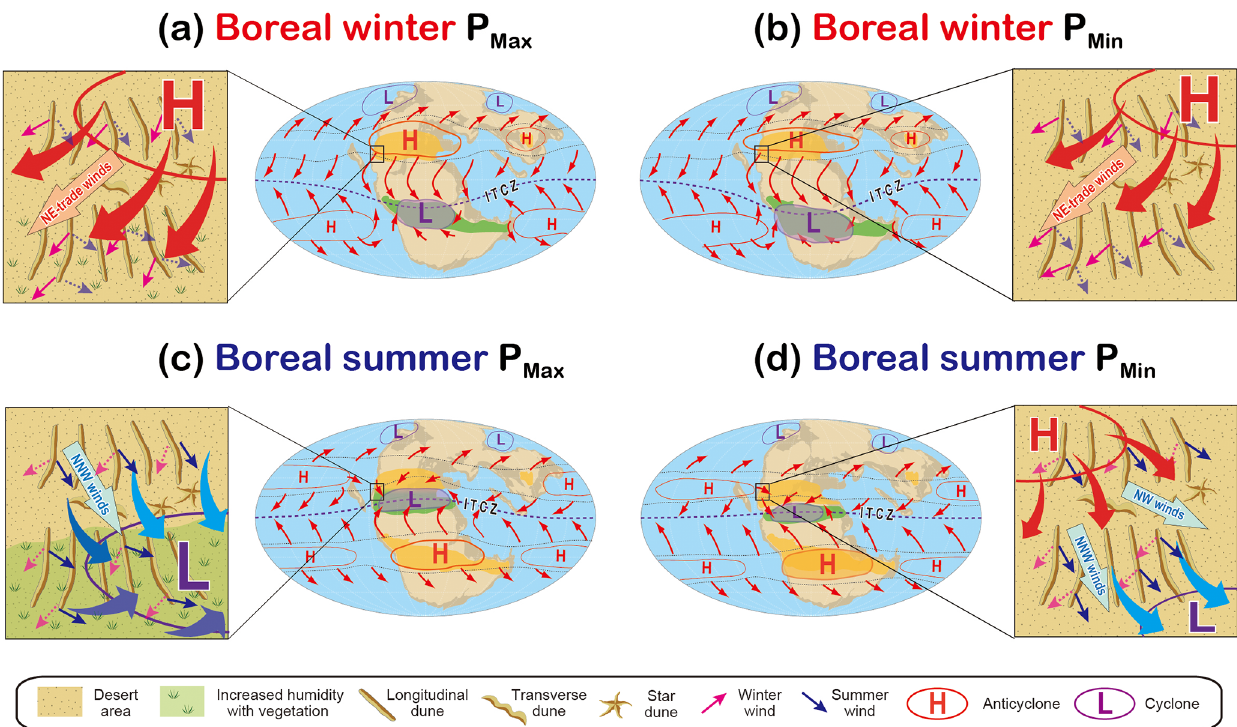
Figure 4. Schematic illustrations of orbital and seasonal changes in the Pangaean atmospheric pressure pattern and inferred dune alignments in the western US during the eccentricity-modulated precession maximum ( P Max ; a, c ) and minimum ( P Min ; b, d ). Orbital-scale changes in the pressure pattern are based on climatic model results (Winguth and Winguth, 2013). Seasonal changes in wind regimes are indicated as pink (boreal winter) and blue (boreal summer) arrows. During the eccentricity-modulated precession maximum, the continental low-pressure system in the boreal summer was likely reduced by a few hPa relative to the eccentricity-modulated precession minimum in response to the increase in surface temperature (Winguth and Winguth, 2013). Increased moisture and vegetation cover likely resulted in dune stabilization in the southern area during the boreal summer at the eccentricity-modulated precession maximum (c)